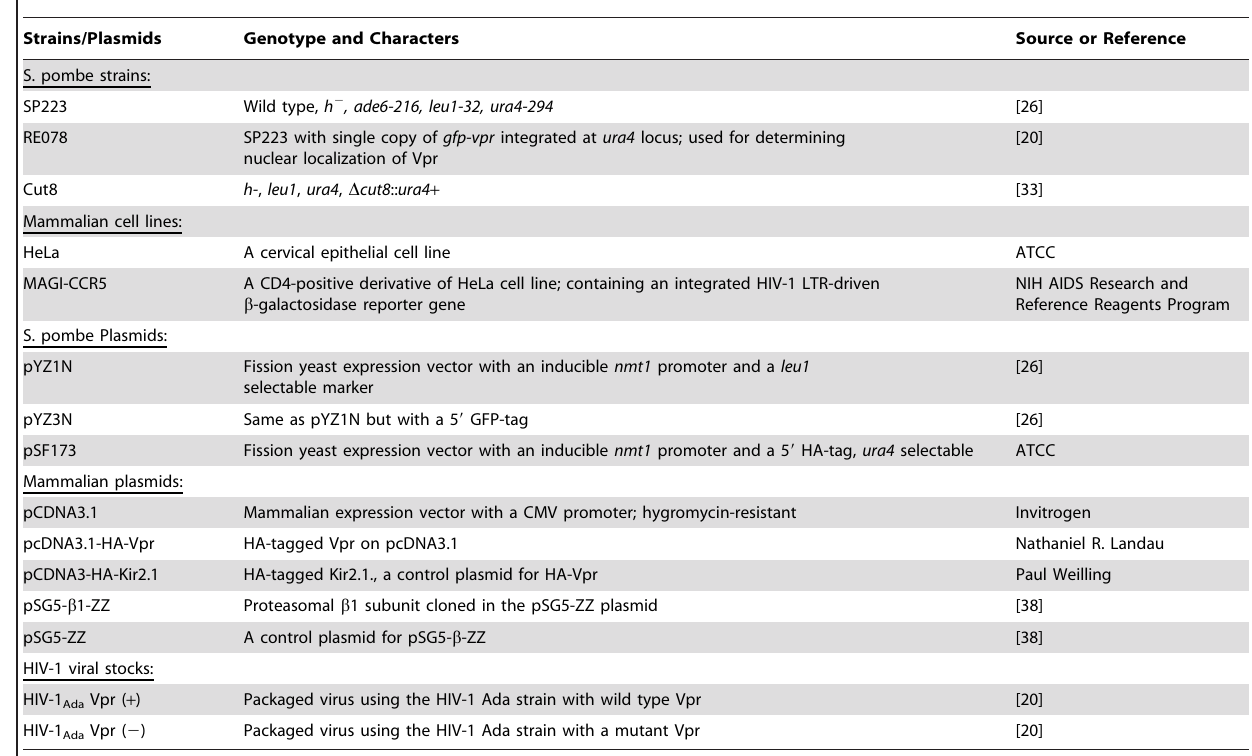
Table 1. Fission yeast strains, human cell lines, plasmids and HIV-1 viral stocks.